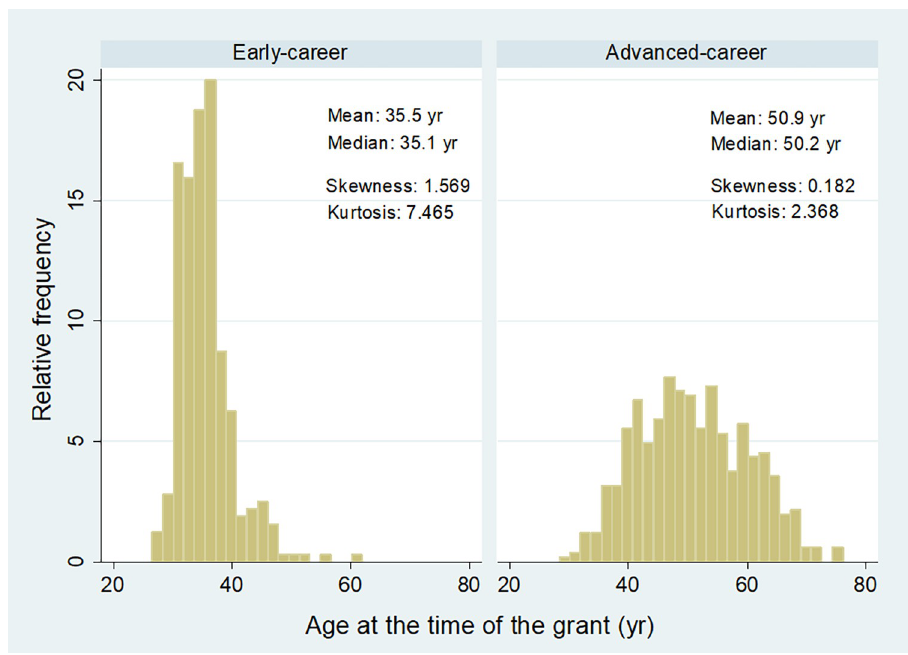
Fig 6. Distribution of the age of the PI at the time of the grant and distribution statistics for early and advanced grant types across all grants awarded by the Estonian Research Council between 2013–2022.